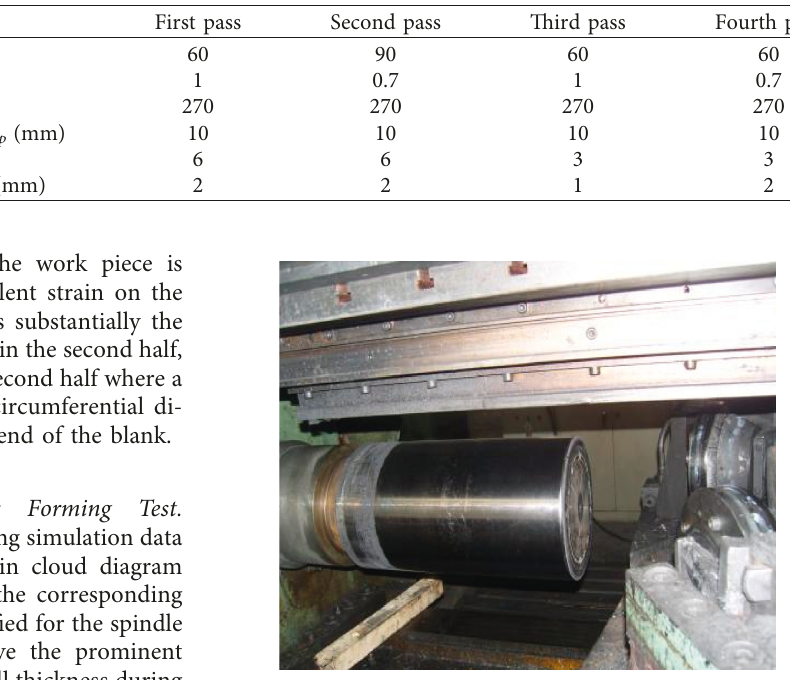
Figure 15: Hot rotary core mold installation state.